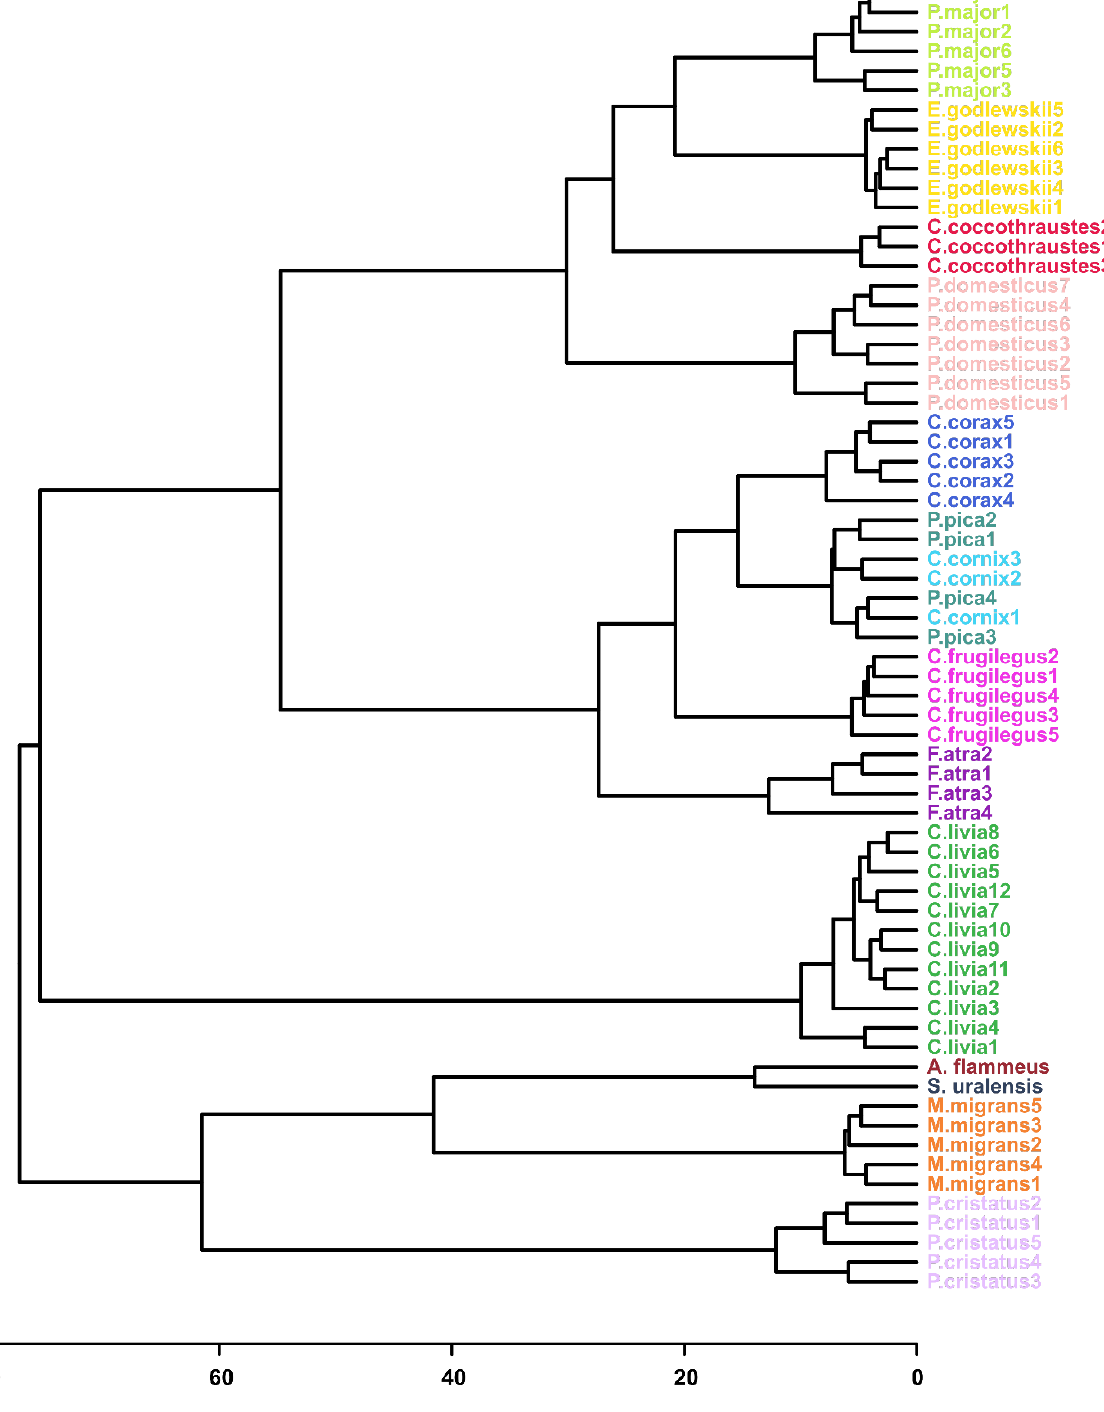
Figure 3. The HCA result shown as a dendrogram. The data are auto-scaled, the distance similarity measure is Euclidean and the cluster ing algorithm is Ward’s linkage